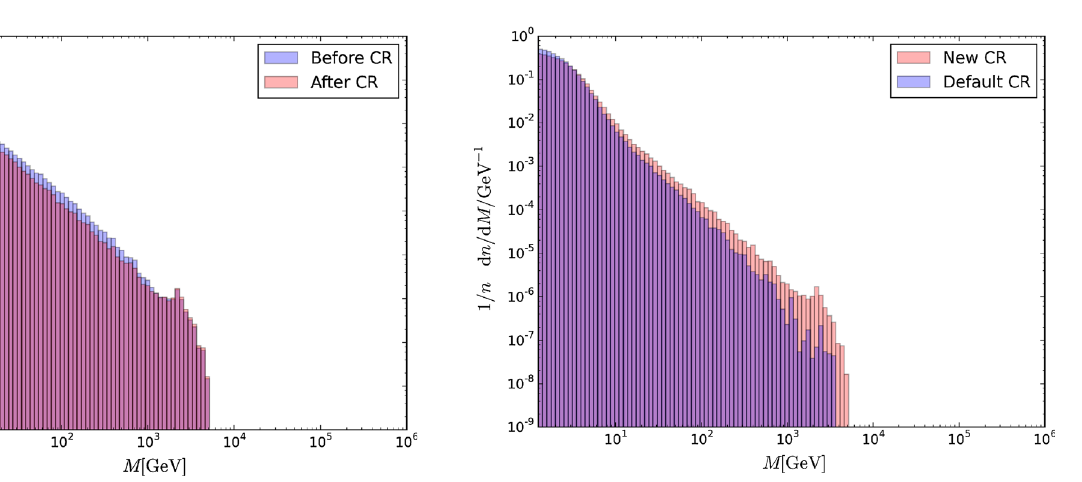
Fig. 16 Comparison between the distributions of invariant cluster masses before and after the colour reconnection